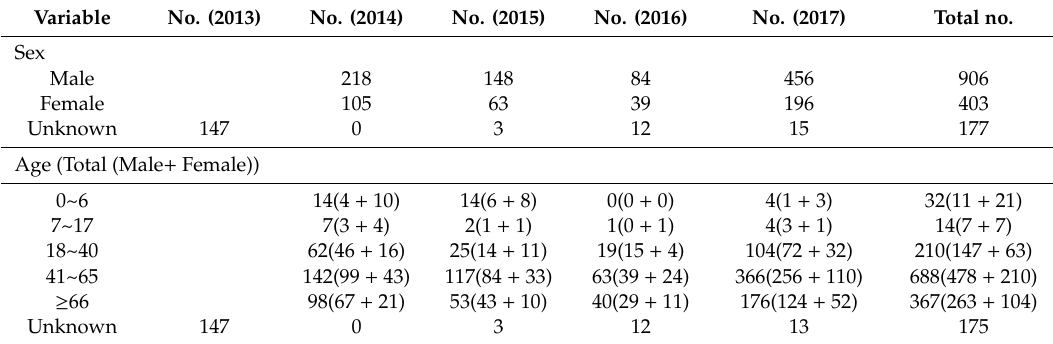
Table 1. The statistical description for the collected data at the individual